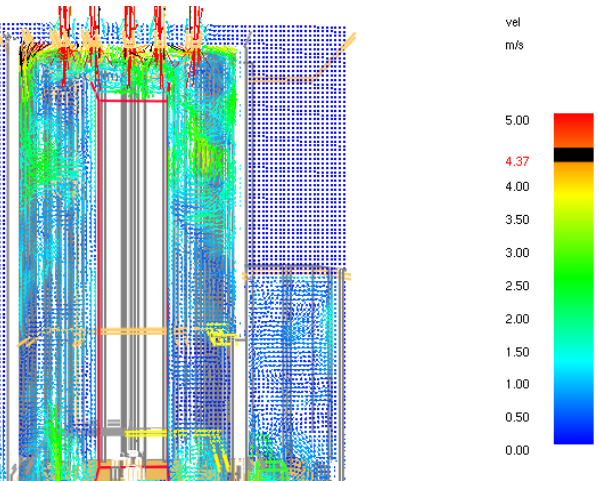
Figure 7. Distribution of air flows in the boiler house under regular operating conditions.